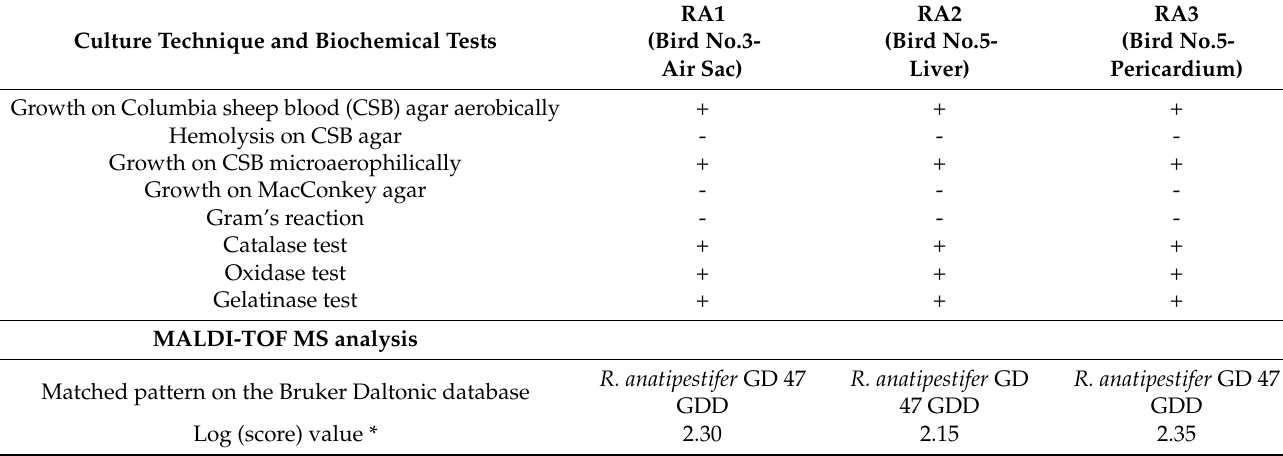
Table 1. Identification of Riemerella anatipestifer from broiler chicken tissues using culture, staining and biochemical tests and matrix-assisted laser desorption/ionization time-of-flight mass spectrometry (MALDI-TOF MS) analysis based on the Bruker Daltonic